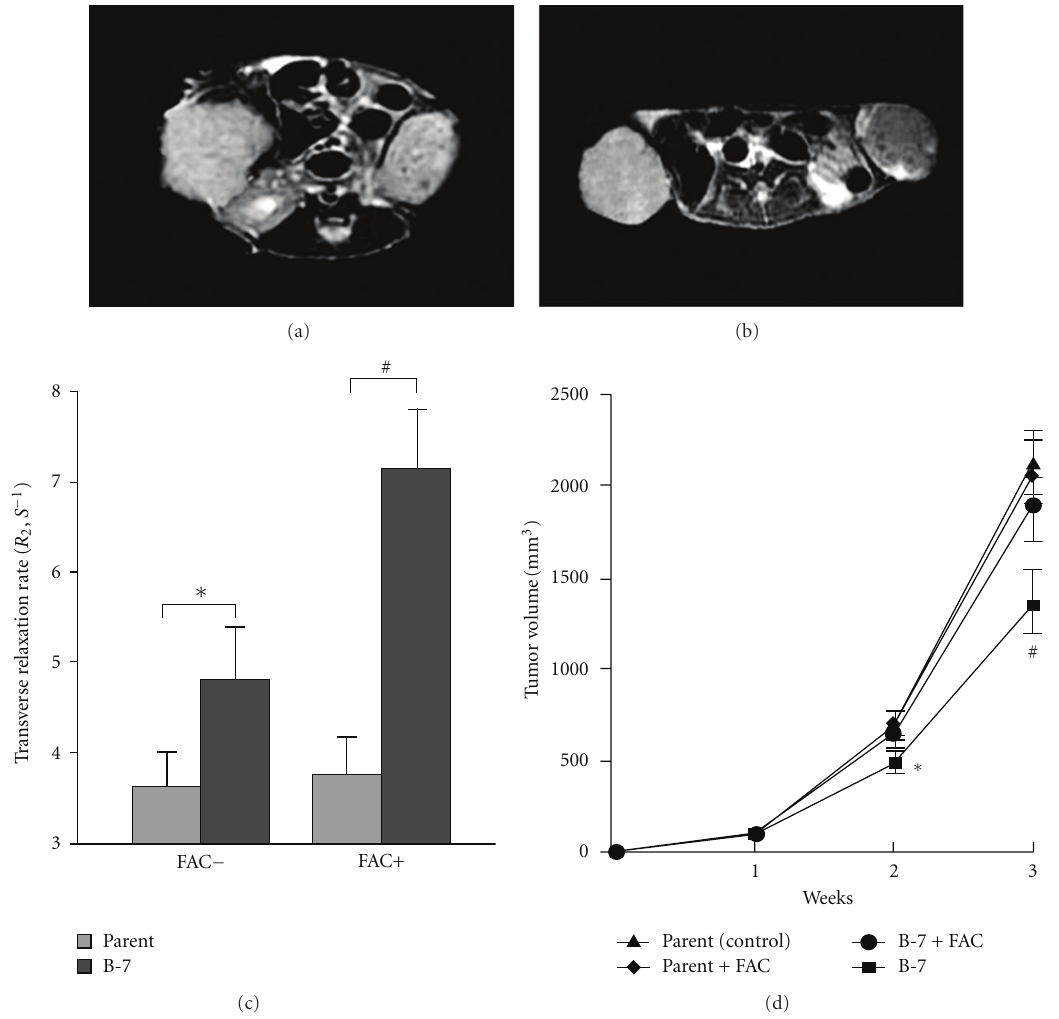
Figure 6: MRI of tumors over-expressing FTH1 in vivo . Representative T 2 -wighted images of mice with inoculation of B-7 cells (right) and parent cells (left) were acquired at 21 days postinoculation without (a) or with (b) FAC supplementation in the drinking water. (c) R 2 at the tumor region. (d) E ff ects of FTH1 overexpression on the tumor growth. B-7 cells and parent cells were inoculated into the hind flank of nude mice, and tumor volumes were measured from MR images at the indicated time points. Data were expressed as mean ± SD for 6 experiments. ( ∗ P < 0 . 05 and # P < 0 .